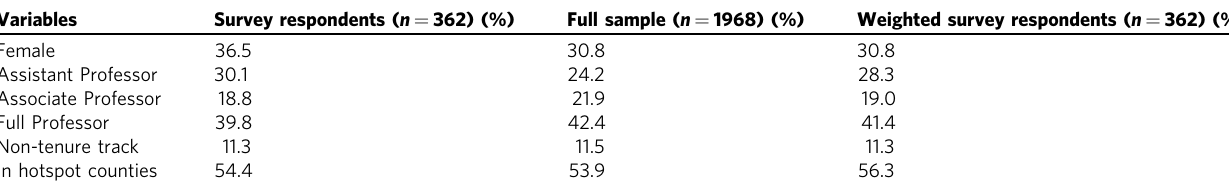
Table 1 Results of nonresponse bias